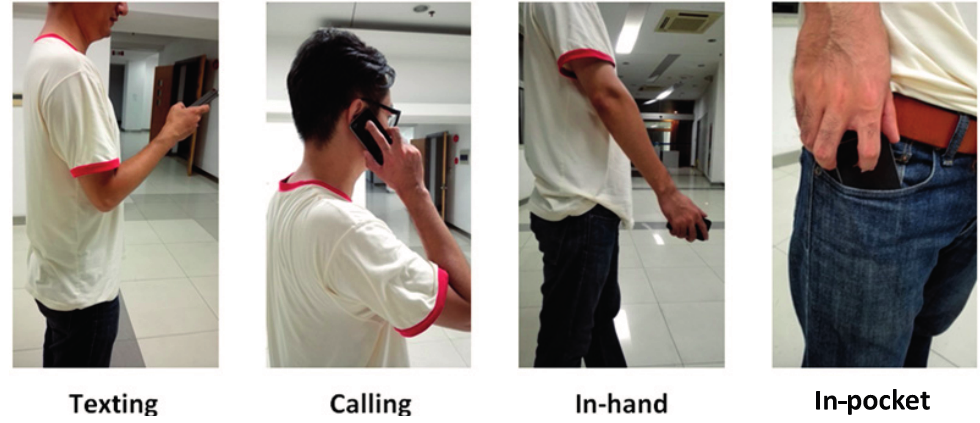
Figure 2. Different contexts of carrying a smartphone in daily